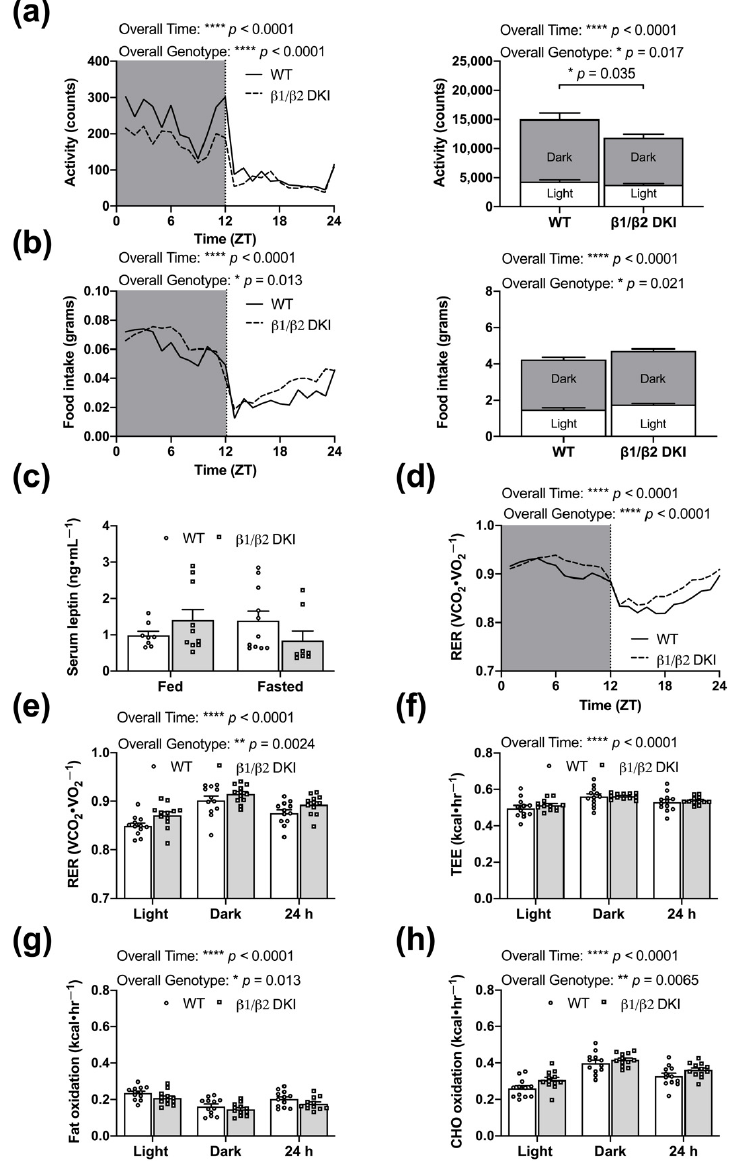
Figure 2. DKI mice have reduced voluntary activity and reduced rates of fat oxidation. Male DKI mice and age-matched WT controls were housed in metabolic cages and activity, food intake, oxygen consumption (VO 2 ), and carbon dioxide production (VCO 2 ) were measured every 18 min across ~60 h (after initial ~6 h acclimatization period). Activity data represent the total beam breaks in the x-ambulatory field. Hourly, 12 h light and dark phases (Zeitgeber time; ZT), and 24 h averages were calculated for activity and food intake. ( a and inset ) DKI had lower ambulatory activity, specifically during the dark phase, and ( b and inset ) a main effect for increased food intake, but no significant differences in either the light or dark cycles. ( c ) The main effect of increased food consumption was not associated with changes in serum leptin concentration in the fed or 6 h fasted states. ( d , e ) Respiratory exchange ratio (RER) was calculated and averaged for hourly, phase, and 24 h measures. ( f ) Total energy expenditure (TEE), ( g ) rates of fat oxidation, and ( h ) rates of carbohydrate (CHO) oxidation were calculated and averaged across the light, dark, and 24 h cycle. Fed male mice, n = 12, 12–16 wk. * p < 0.05, ** p < 0.01, **** p <